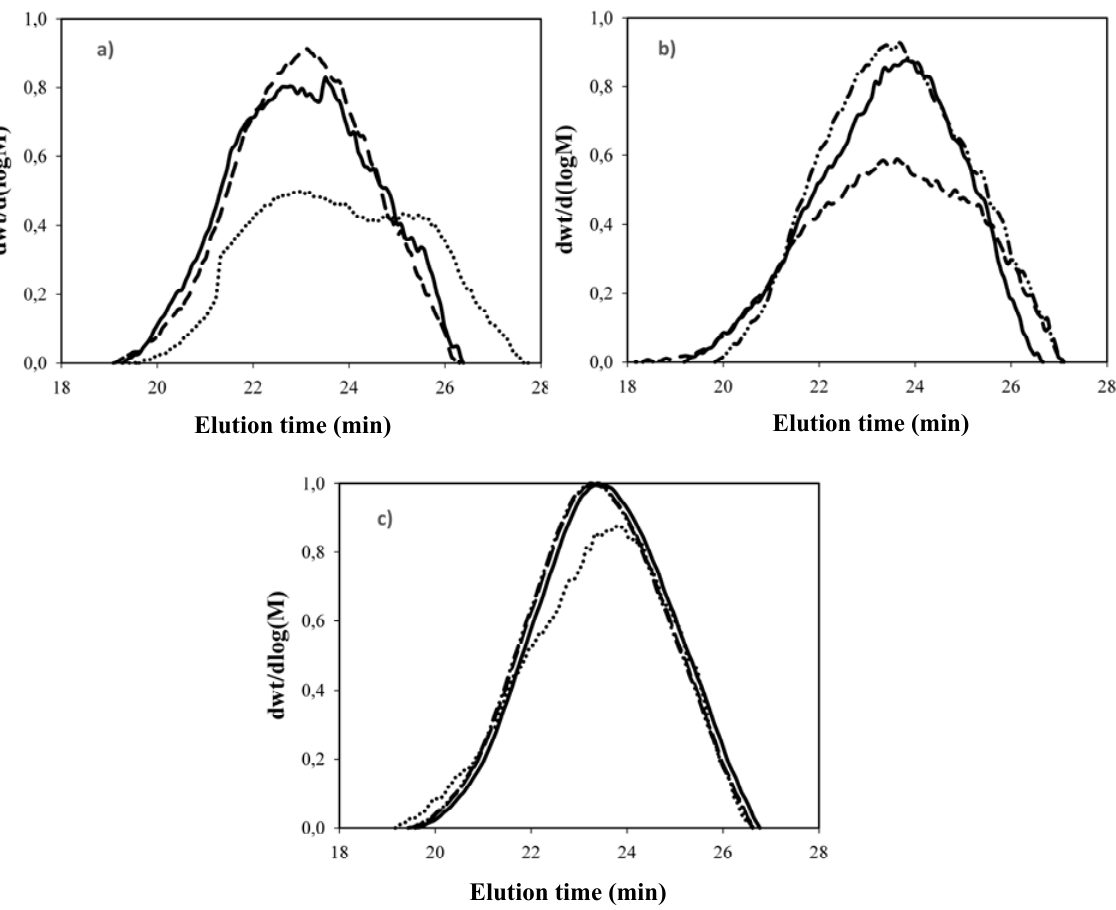
Figure 2. Size exclusion chromatography (SEC) chromatograms obtained for runs 2 ( a ), 3 ( b ) and 4 ( c ). 30 min (dotted), 60 min (solid), 120 min (medium dash), 180 min (dash dot).